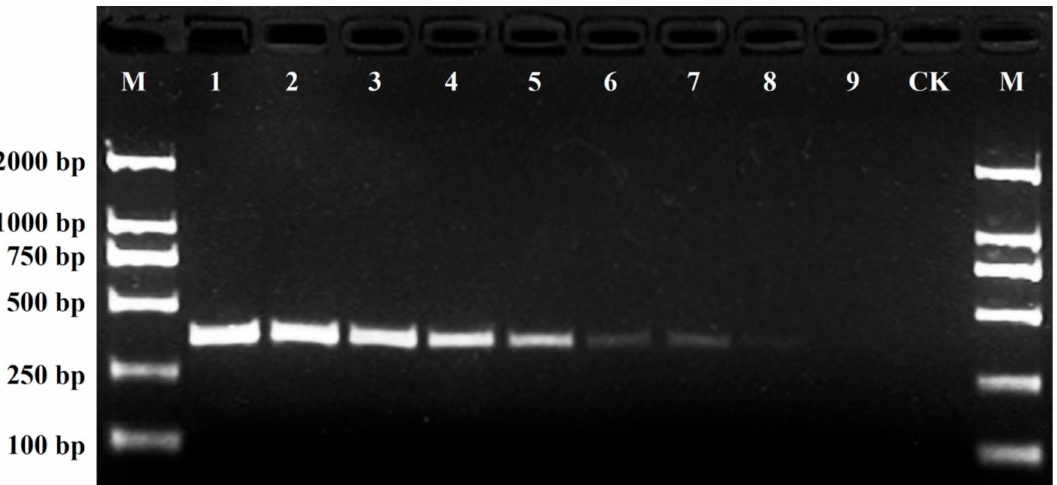
Figure 5. The sensitivity of the SCAR markers (DBJF/DBJR) with different C. morifolium ‘Daboju’ genomic DNA concentrations in a 20 µ L PCR mixture. Lane M: Trans2K DNA Marker with specified amplification product band lengths (bp); lanes 1–9: 50 ng/ µ L, 40 ng/ µ L, 30 ng/ µ L, 20 ng/ µ L,